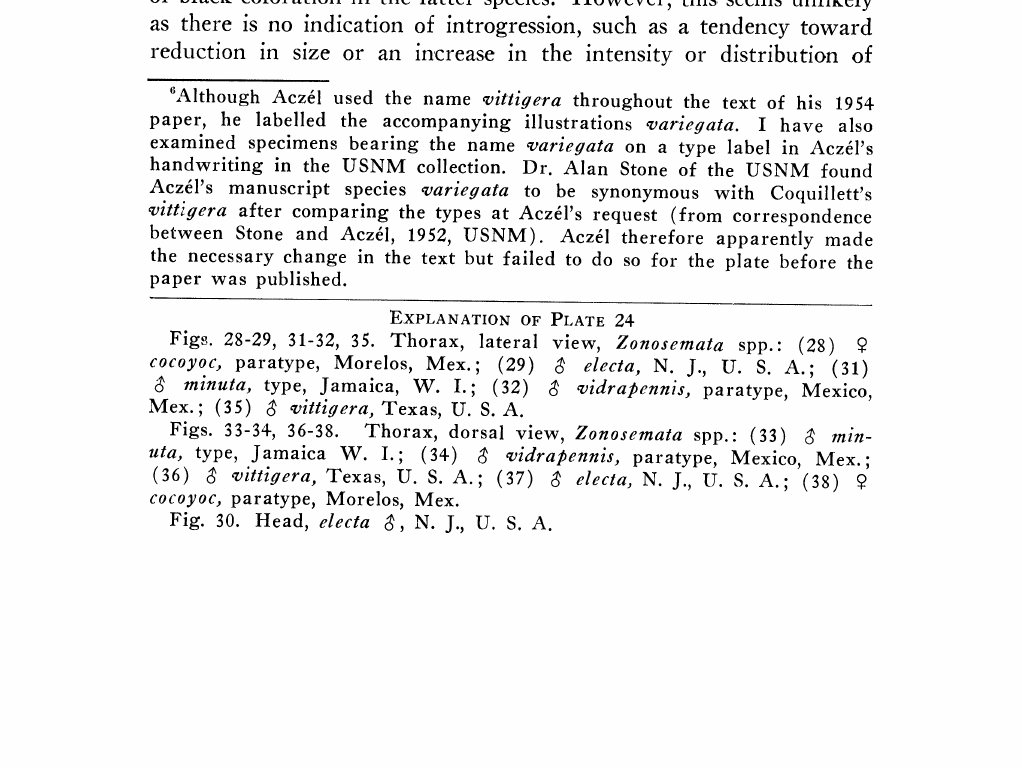
Fig. 30. Head, electa 8, N. J., U. S.